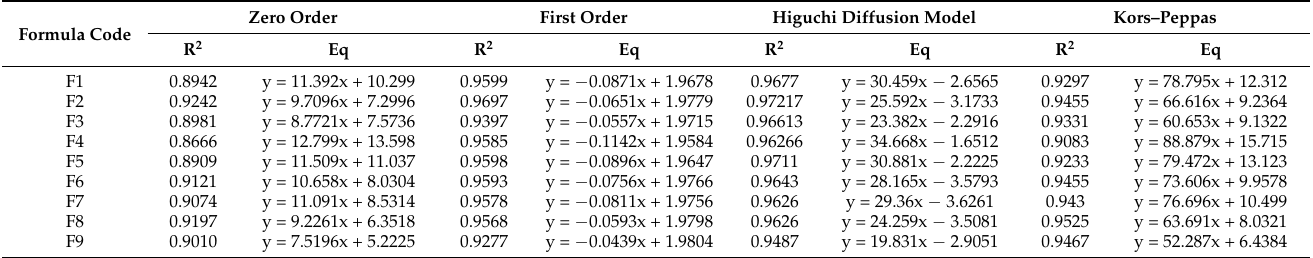
Table 3. Correlation Coefficient of release of QTF presented by different release kinetics equations.